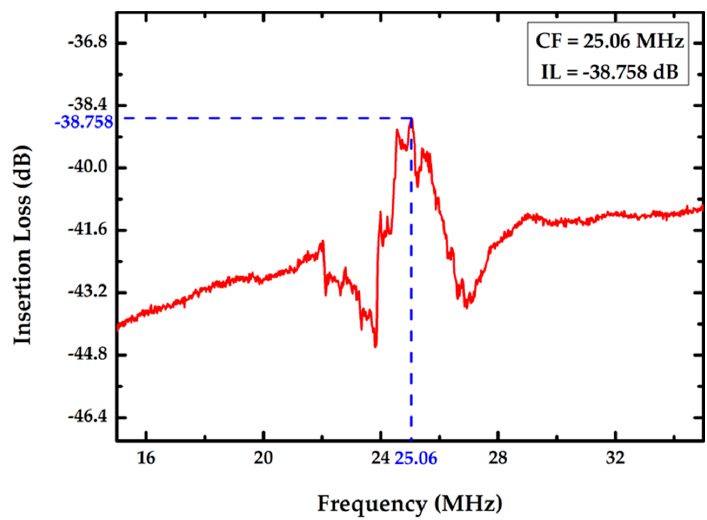
Figure 5. Frequency responses of the proposed FPW device.